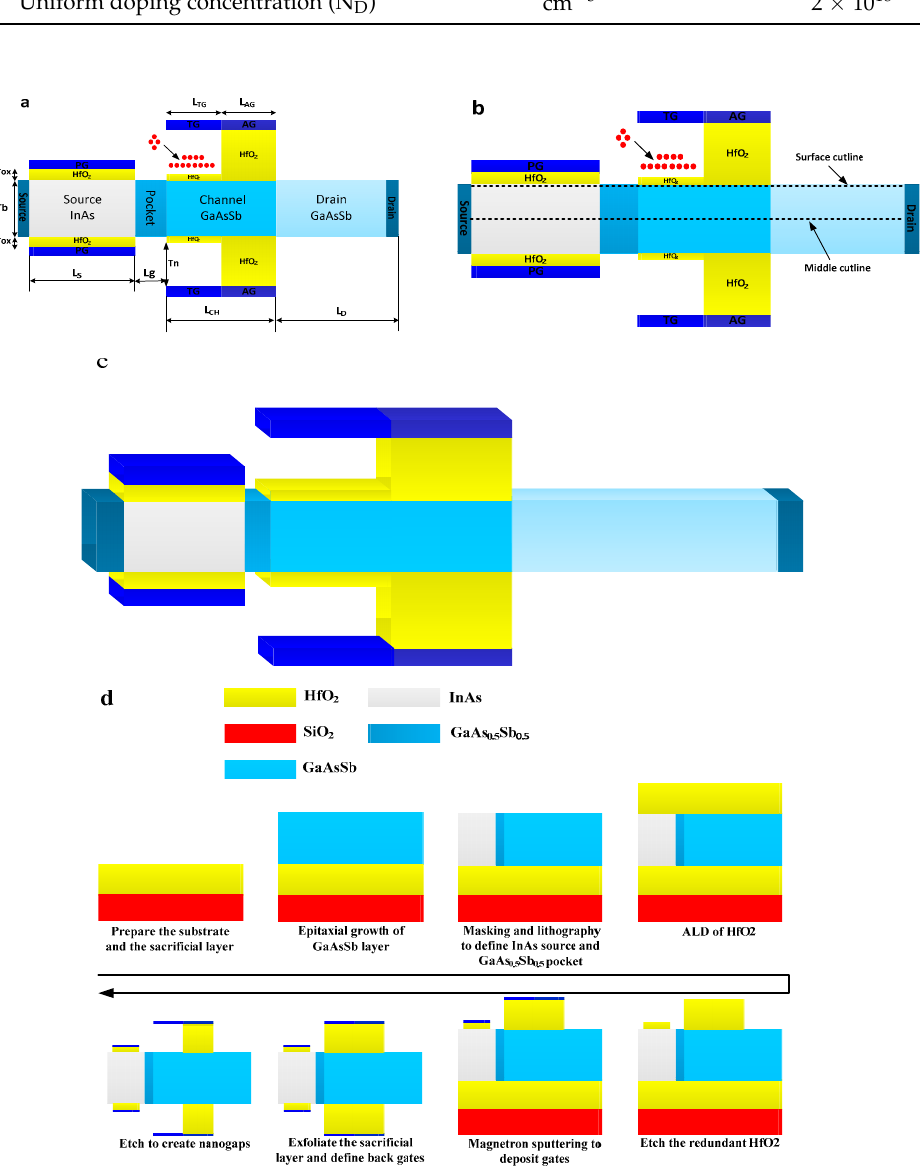
Figure 1. ( a ) Cross-sectional view of DMG-HJLTFET biosensor; ( b ) section diagram of cutting lines; ( c ) 3-D graphic of DMG-HJLTFET; ( d ) tentative fabrication flow of DMG-HJLTFET. Table 1. The fundamental geometrical and physical parameters of the DMG-HJLTFET.